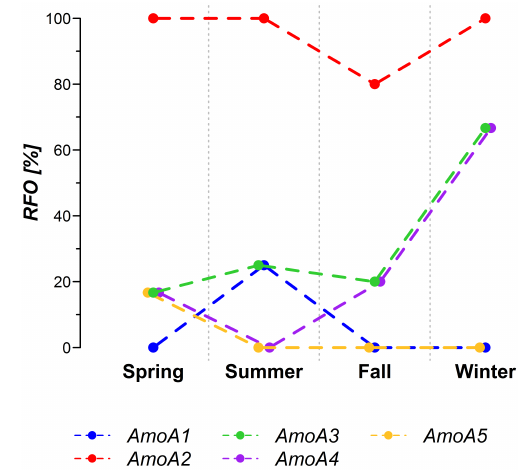
Figure 5. Seasonal variations in the relative frequency of occur- rence (RFO) of the individual amoA OTUs detected in Mainz, Ger-